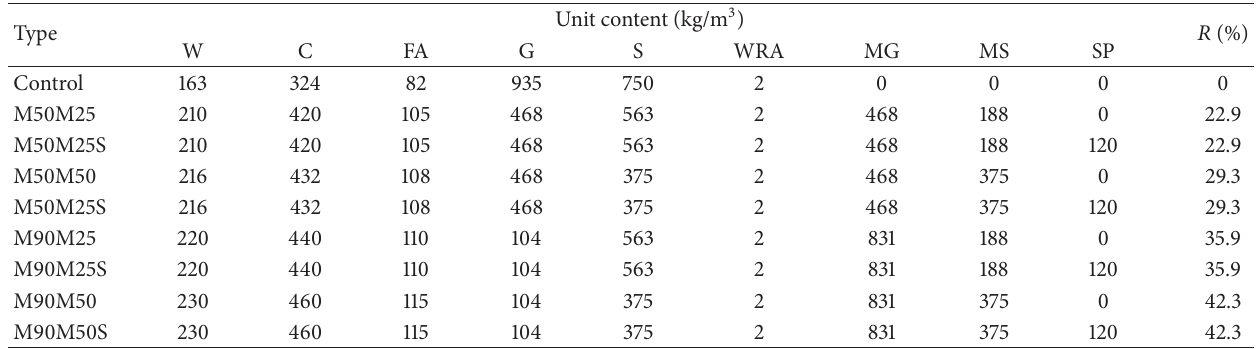
Table 1: Mix proportions for concrete test.